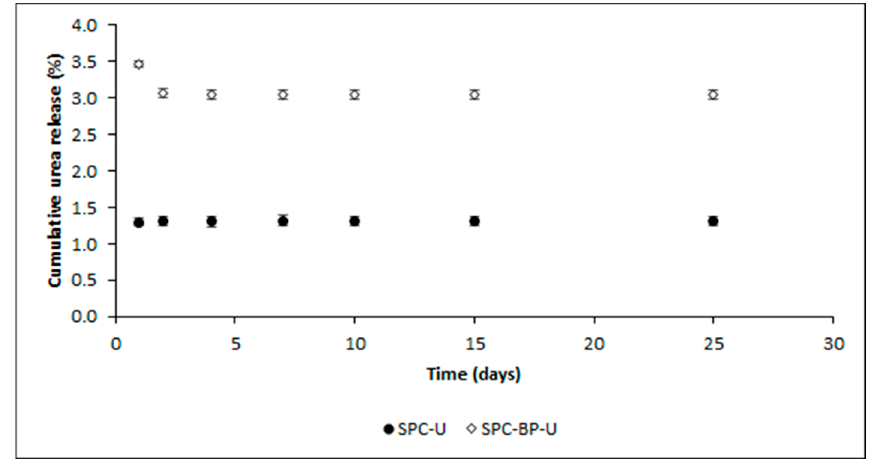
Figure 8. Cumulative urea N released expressed as percentage of the initial urea